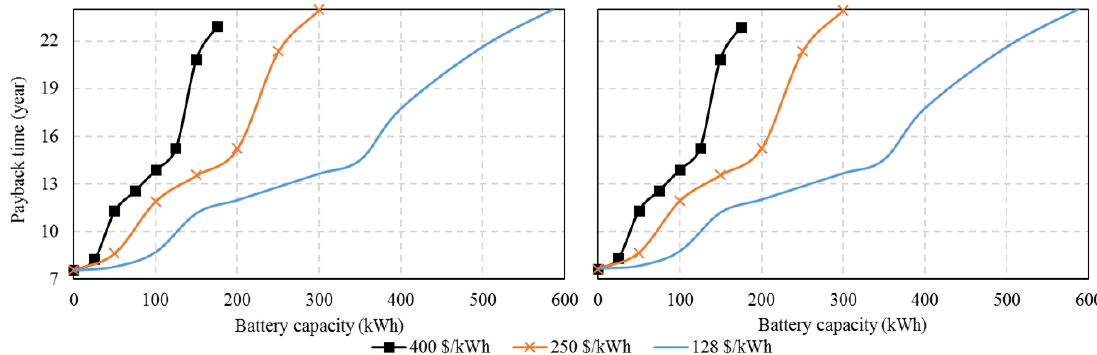
Figure 9. The effect of the battery capacity on the payback time of the PV system for: Feed-in tariff = 6.7 ₵ /kWh ( left ), and 3.35 ₵ /kWh ( right ). Annual saving target 25%.